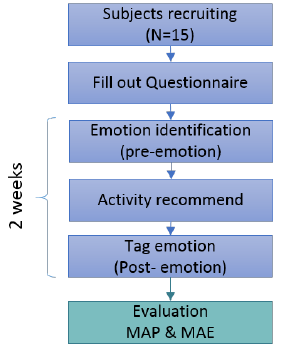
Figure 5 Process of the experiment